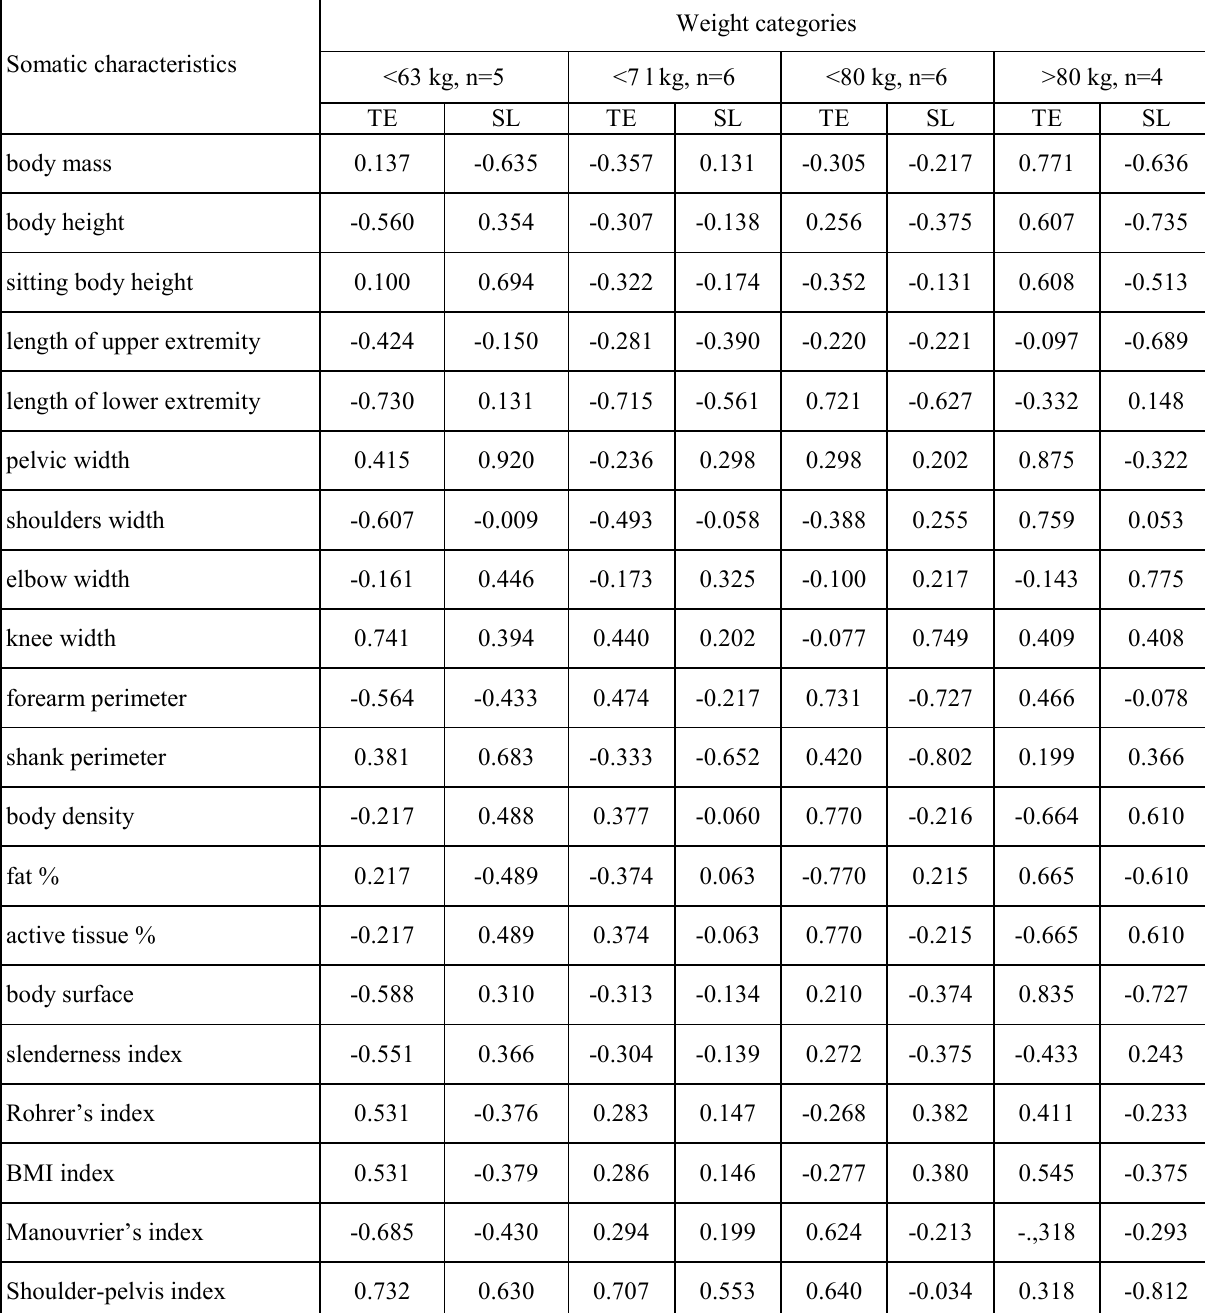
Correlations of somatic characteristics with the training experience (TE) and the sports level (SL)